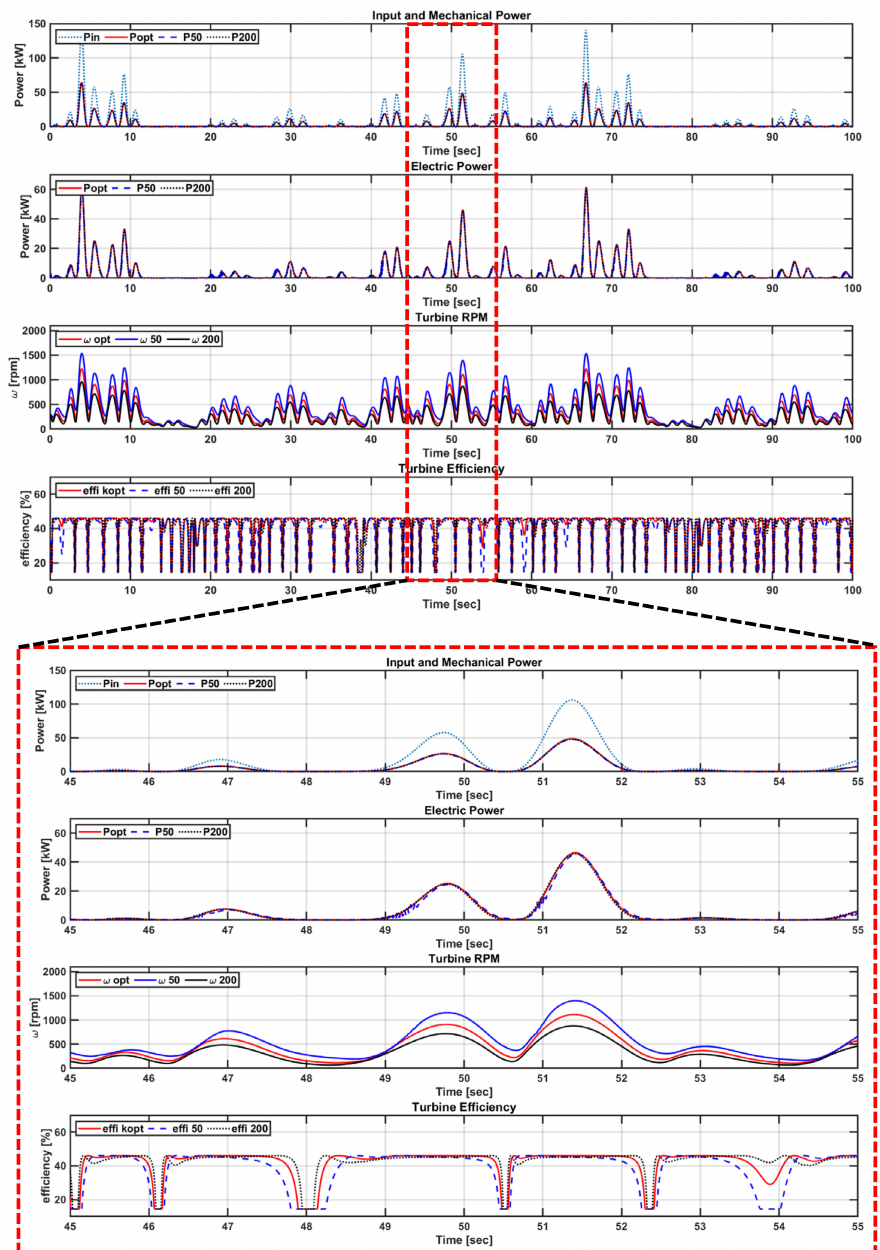
Figure 26. PTO system results in integrated simulation according to the torque factor of PWM converter under irregular wave ( v t = 0~42 m / s and Tp = 4.75 s) input conditions: Input instantaneous power generation, mechanical instantaneous power generation, electrical instantaneous power generation, turbine rpm, and e ffi